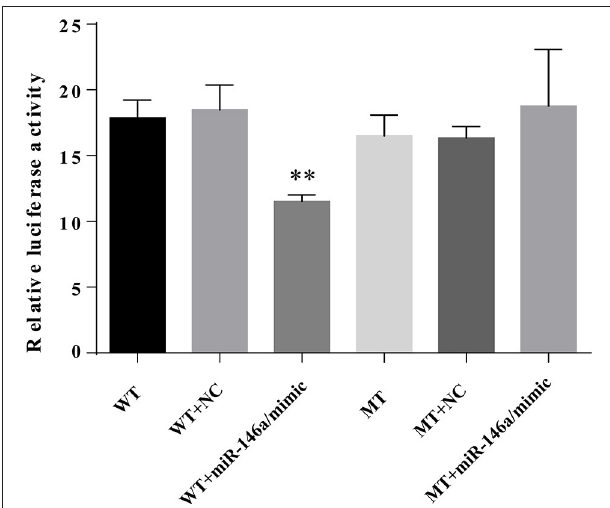
FIGURE 11 | miR-146a directly targets TXNIP 3 ′ UTR. VSMCs were transiently co-transfected with PGL3-CMV-LUC-MCS-TXNIP − 3 ′ UTR dual luciferase reporter recombinant vector, and miR-146a mimic or NTC mimic. The firefly luciferase activity was detected by Dual Luciferase Reporter Gene Assay